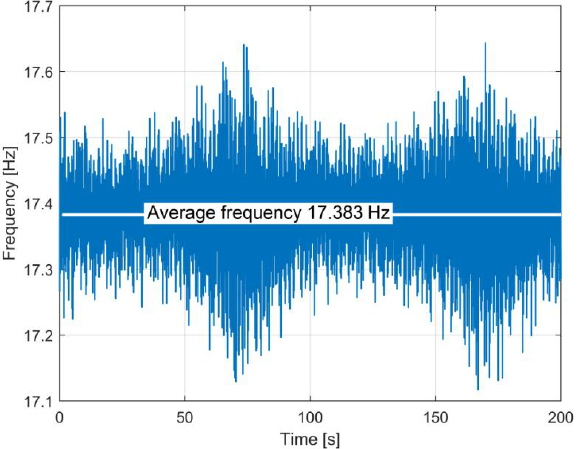
Figure 11. The evolution of the instantaneous combination frequency f c during the vibration beating phenomenon (displacement of headstock) described in Figure 7.